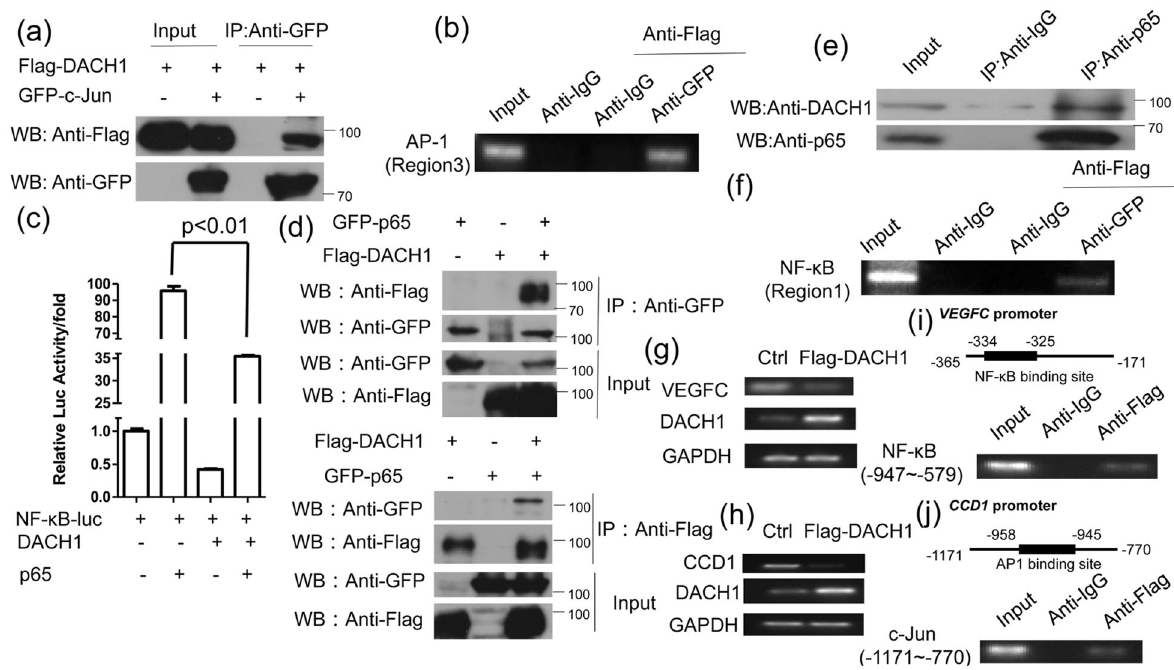
Fig. 4 DACH1 interacts with p65 and c-Jun, respectively. a HEK 293 T cells transfected with Flag-DACH1 alone or both Flag-DACH1 and GFP- c-Jun were subjected to immunoprecipitation with anti-GFP antibody followed by Western blot with anti-Flag antibody. b HEK 293 T cells were transfected with Flag-DACH1 and GFP-c-Jun. After 24 h of transfection, DNA-protein complex were immunoprecipitated with anti-IgG or anti- GFP antibody, followed by re-immunoprecipitation with anti-Flag antibody. AP-1 binding site (region 3) was ampli fi ed by PCR. c HEK 293 T cells were transfected with pNF- κ B-Luc and either DACH1 or p65, DACH1 and p65. Luciferase activity was measured 24 h after transfection. d HEK 293 T cells transfected with Flag-DACH1 and GFP-p65 were subjected to immunoprecipitation with anti-GFP antibody followed by Western blot with anti-Flag antibody or vice versa. e ZR-75-30 cells were subjected to immunoprecipitation with anti-p65 or anti- IgG antibody followed by Western blot with anti-DACH1 antibody. f HEK 293 T cells were transfected with Flag-DACH1 and GFP-p65. After 24 h of transfection, DNA-protein complex were immunoprecipitated with anti-IgG or anti-GFP antibody, followed by re-immunoprecipitation with anti-Flag antibody. NF- κ B binding site (region 1) was ampli fi ed by PCR. There were three independent experiments with three parallel wells each. The data are representative of three independent experiments. Data are presented as means ± SD (P < 0.05, signi fi cant; ns, not signi fi cant). g , h ZR-75-30 cells were transfected with or without Flag-DACH1, and then subjected to the analysis of CCD1 or VEGFC expression by RT-PCR. i , j Up, the schematic structure of NF- κ B binding site in VEGFC promoter or AP1 binding site in CCD1 promoter. Down, ZR-75-30 cells were transfected with Flag-DACH1. Cross-linked chromatin was extracted from the cells and subjected to immunoprecipitation with anti-Flag or IgG antibody. The DNA regions were ampli fi ed by PCR. IgG was used as a negative